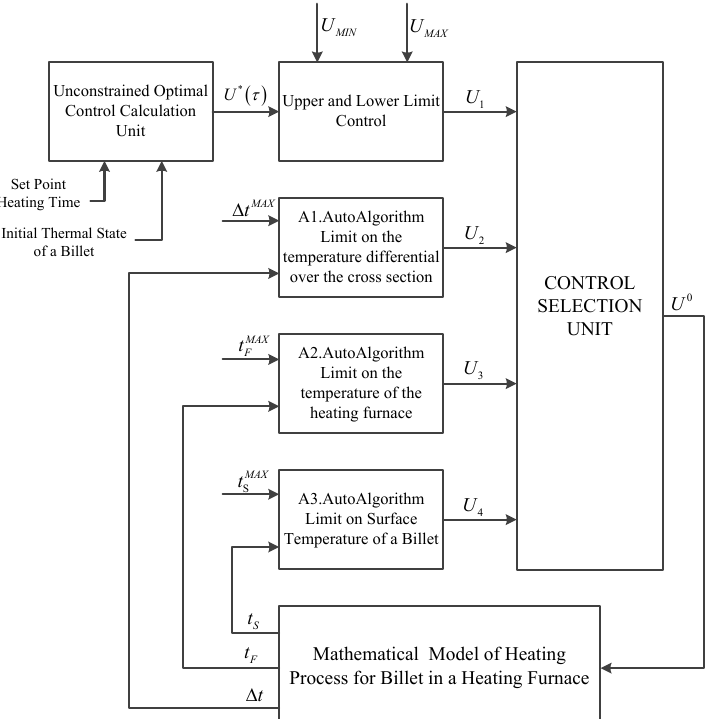
Figure 2. Selecting the optimal metal heating control path to minimize fuel costs in compliance with the process constraints.